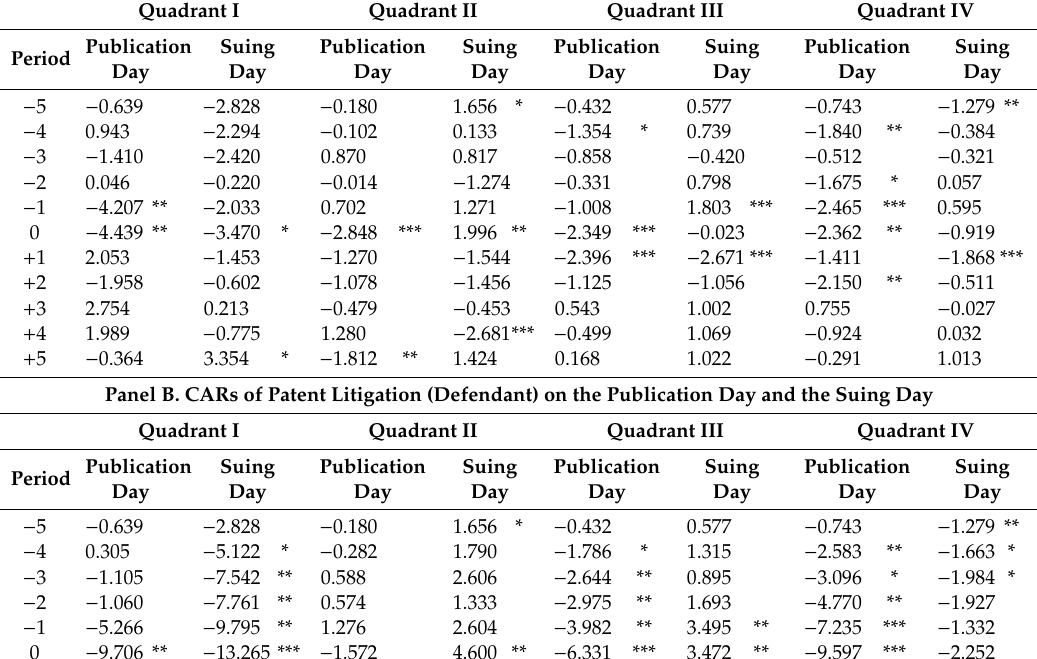
Table 3. ARs and CARs of patent litigation (defendant) on the publication day and the suing day in the di ff erent